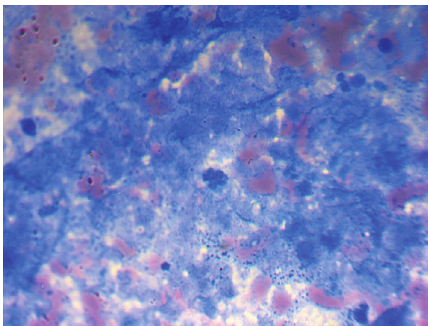
Figure 2: Core needle biopsy showing caseous necrosis and stain for AFB positive.